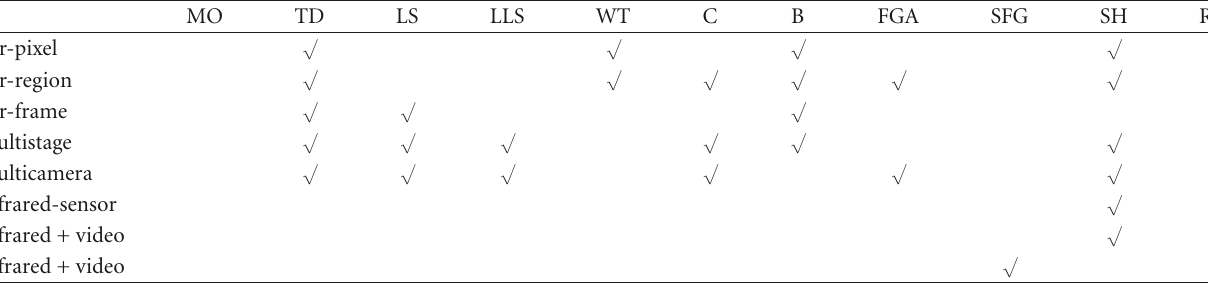
Table 1: A summary of the methods discussed in this paper, associated with the problems they solve. The meaning of the abbreviations is reported in the